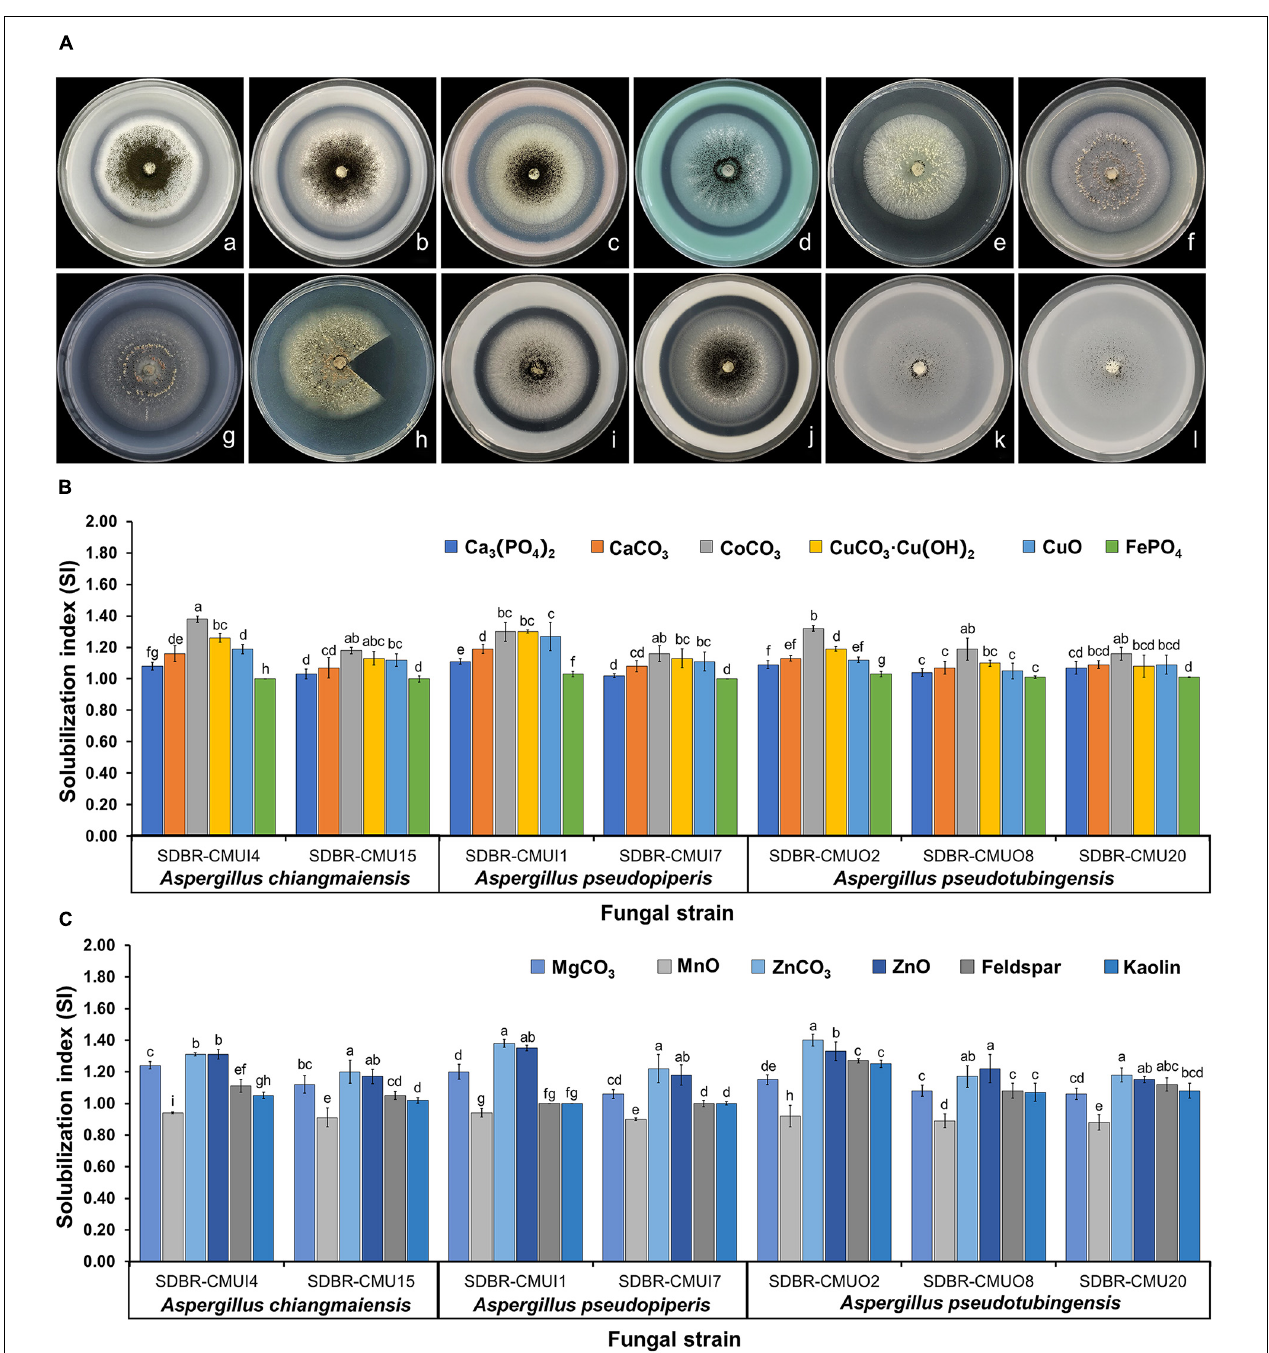
FIGURE 5 | Solubilization of insoluble minerals in agar media by the mineral-solubilizing fungi (A) and solubilization index of the ability to solve insoluble minerals (B,C) . Error bars represent the standard deviation of the mean. The different letters indicate significant difference ( p ≤ 0.05). A. chiangmaiensis SDBR-CMUI4 on basal medium contained of Ca 3 (PO 4 ) 2 (a) , CaCO 3 (b) , CoCO 3 (c) , CuCO 3 · Cu(OH) 2 (d) ; A. pseudopiperis SDBR-CMUI1 on basal medium contained CuO (e) , FePO 4 (f) , MgCO 3 (g) , MnO (h) ; A. pseudotubingensis SDBR-CMUO2 on basal medium contained ZnCO 3 (i) , ZnO (j) , feldspar (k) , kaolin (l) . Scale bars: (a–l) 10 mm. Fungal colony in h was cut for observing a solubilization area (halo zone) beneath the fungal